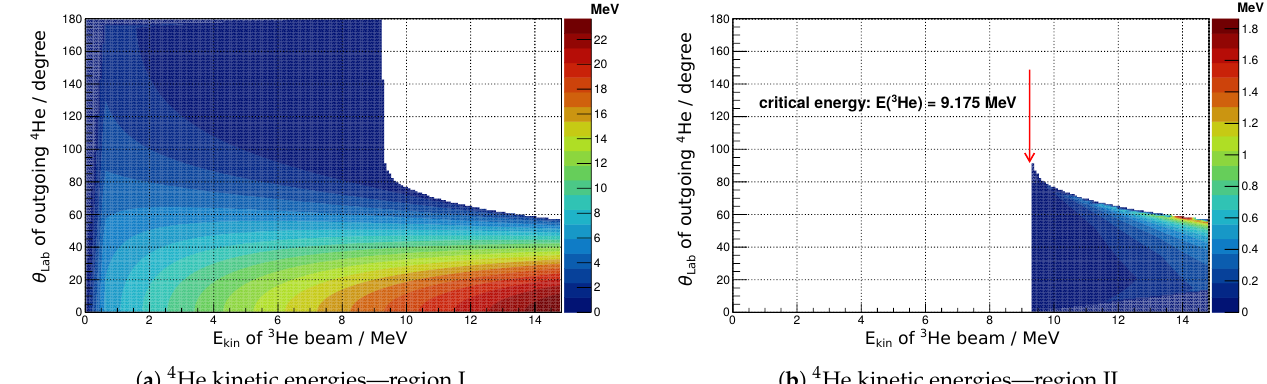
Figure 6. Kinetic energy of α particles emitted from the d - 3 He fusion reaction vs. 3 He beam energy and outgoing polar angle in the Lab frame. When the 3 He beam energy is above the critical energy, there is an upper limit of 4 He outgoing polar angle at each point of beam energy, giving two separate regions of kinetic energies marked with I and II. The α particles in region II with much lower energies can be stopped inside the foil